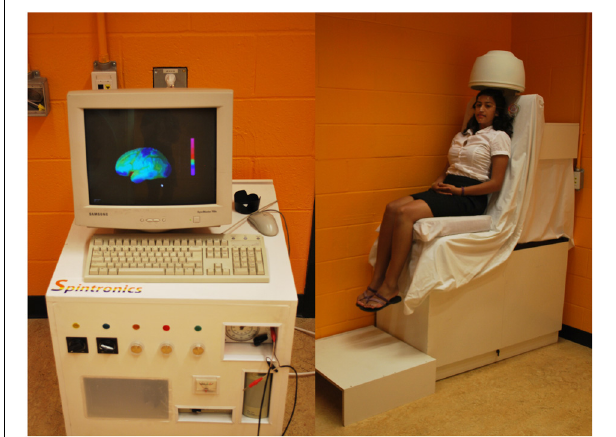
FIGURE 1 | The mock neuroimaging device assembled from discarded odds and ends including a scrap salon hair dryer. Throughout the mock scan, a pre-recorded video displayed rotating three-dimensional brain slices with accompanying scanner-like audio, lending the appearance of collecting and analyzing patterns of brain